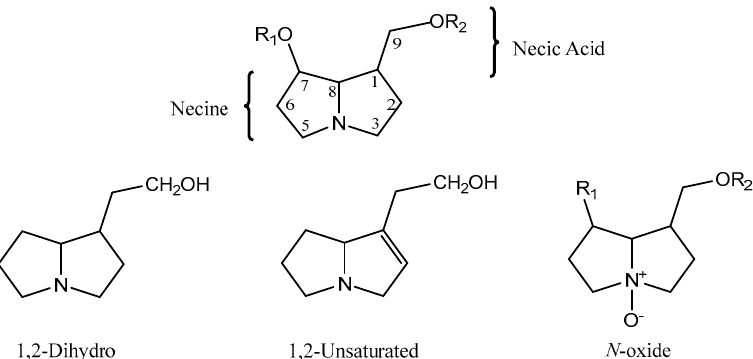
Figure 1. Structure of a PA and its different forms. R 1 and R 2 correspond to different necic acids.